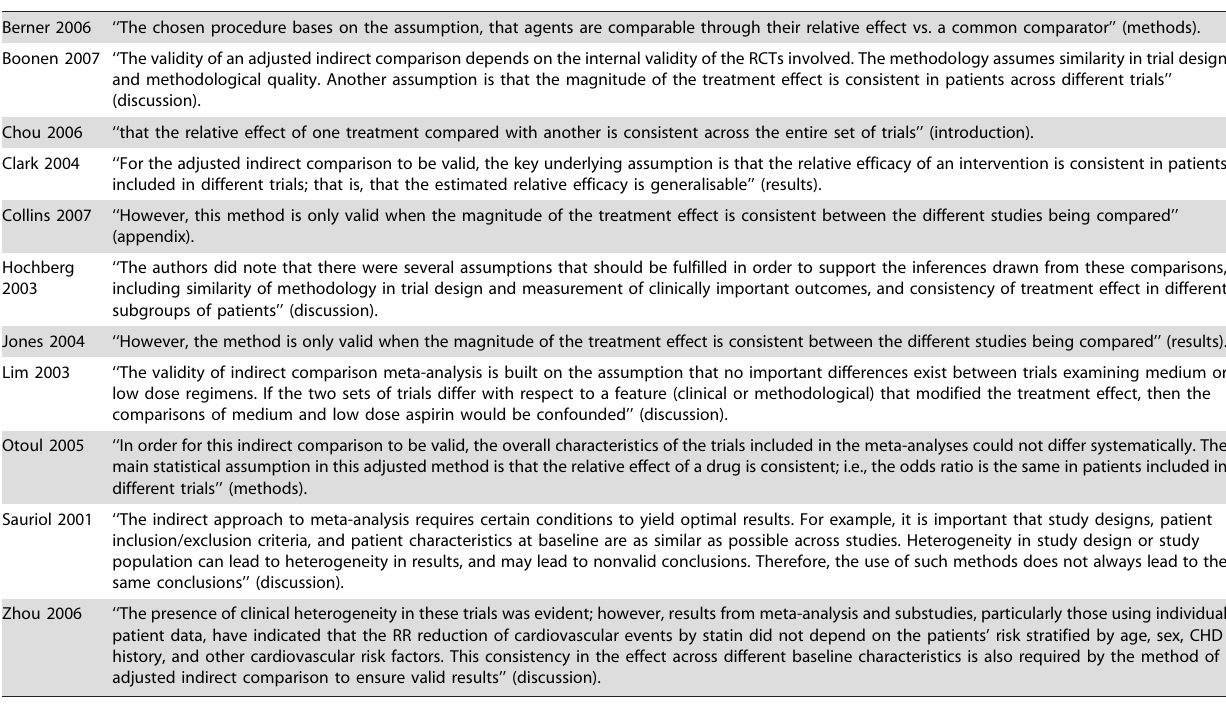
Table 2. Phrasing of the similarity